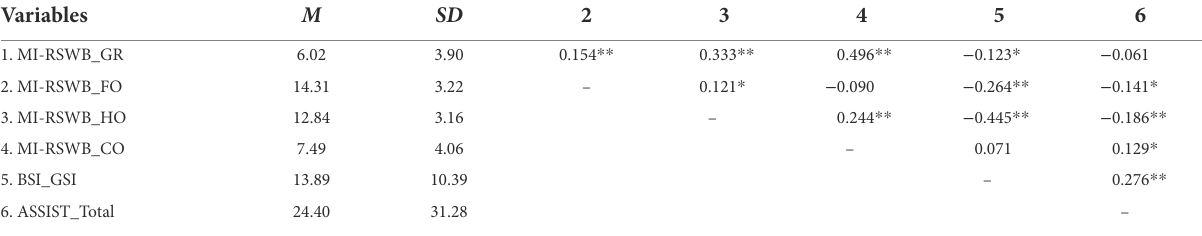
TABLE 1 Means, standard deviations, and bivariate correlations between the study variables of MI-RSWB, BSI, and ASSIST.